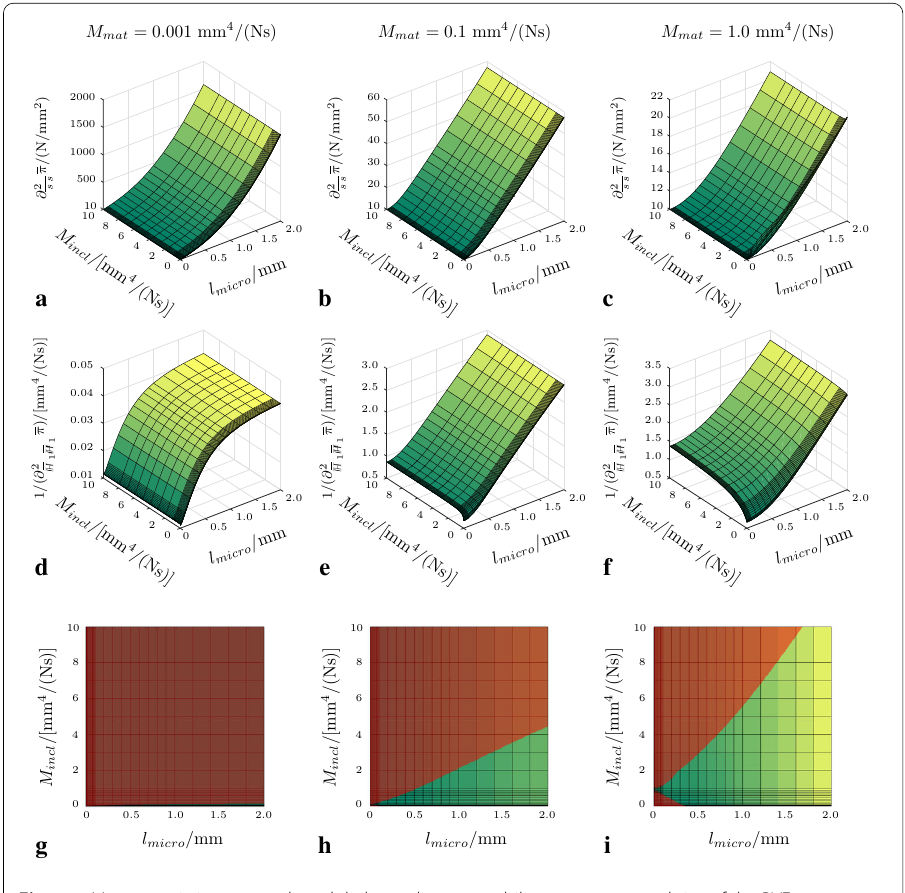
Fig. 11 Macroscopic incremental moduli depending on mobility parameters and size of the RVE. a – c Macroscopic chemical parameter and d – f selected macroscopic mobility parameter depending on the mobility parameter of the matrix M mat = { 0 . 0001 , 0 . 1 , 1 . 0 } mm 4 /(Ns) and the inclusion M incl ∈ [0 . 001 , 10 . 0]mm 4 /(Ns) as well as the size of the RVE l micro ∈ [0 . 002 , 2 . 0]N/mm 2 . g - i Red areas indicate regions of the macroscopic mobility parameter that are bounded from above by the Voigt